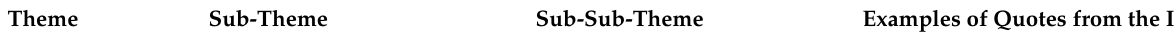
Table 1. Analyzing the first theme according to the thematic